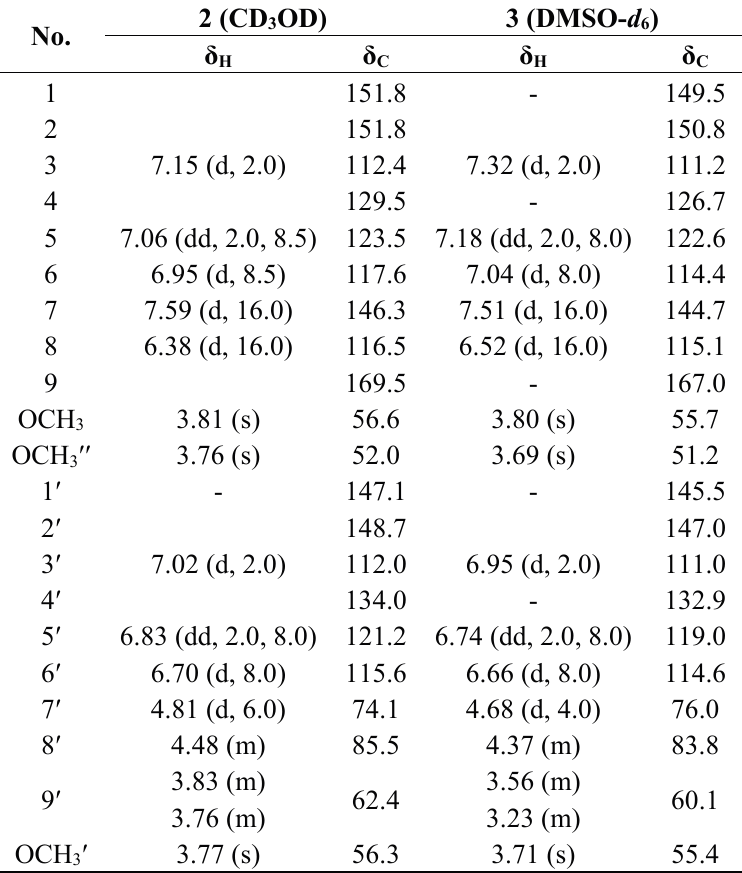
Table 2. 1 H- and 13 C-NMR data for 2 and 3 (500 and 125 MHz, δ